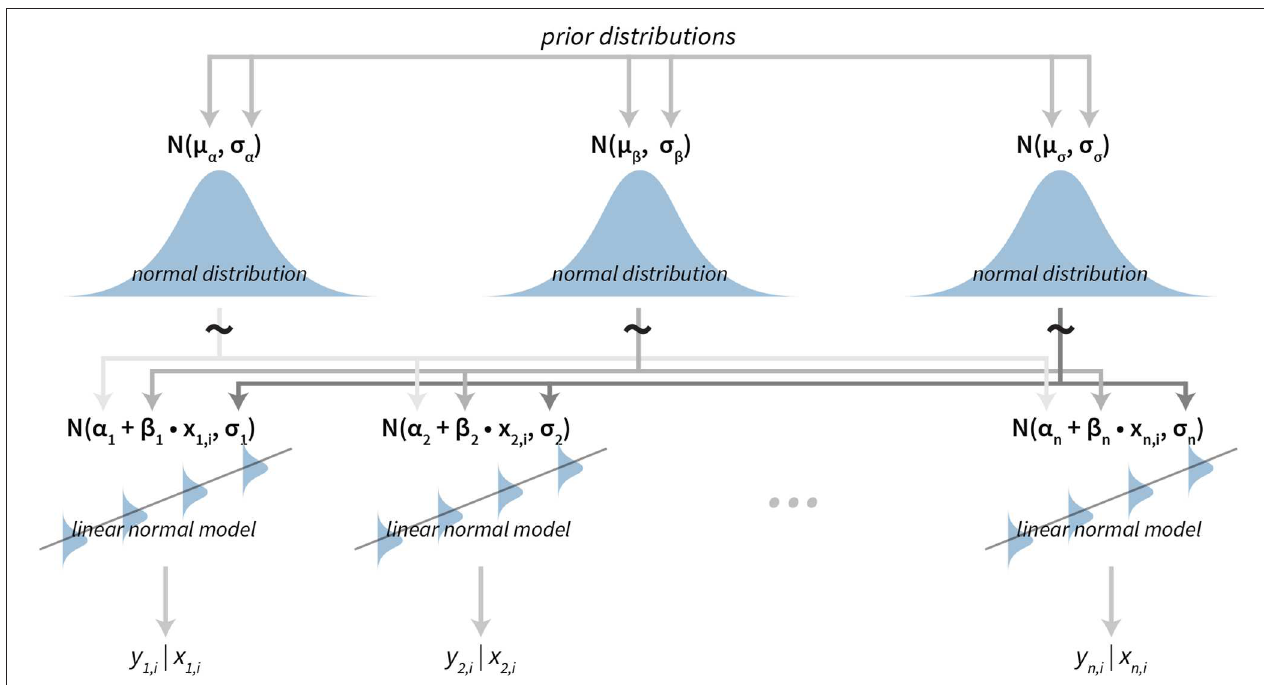
FIGURE 4 | The visualization of the hierarchical linear model. The model has a hierarchical structure, linear normal models are fitted on the subject level from data belonging to each particular subject. Since the ordering is important input data come in pairs of dependent (e.g., result or answer) and independent variables (e.g., time or the question index). The term y n , i | x n , i is the value of the i -th dependent variable given the value of the independent variable i for the subject n . Parameters of subject level distributions are joined on the group level by using normal distributions. These group level distributions can then be used for group level analysis of the data.